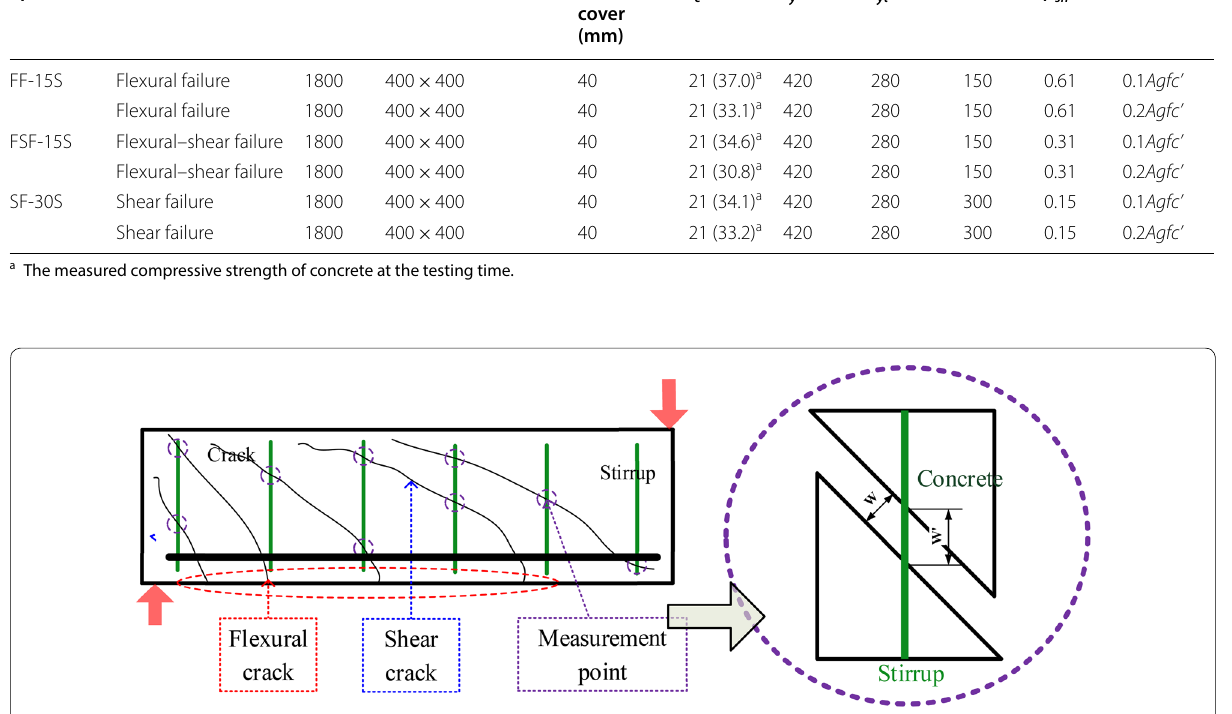
Fig. 6 Measuring cracks of various types at various positions in a